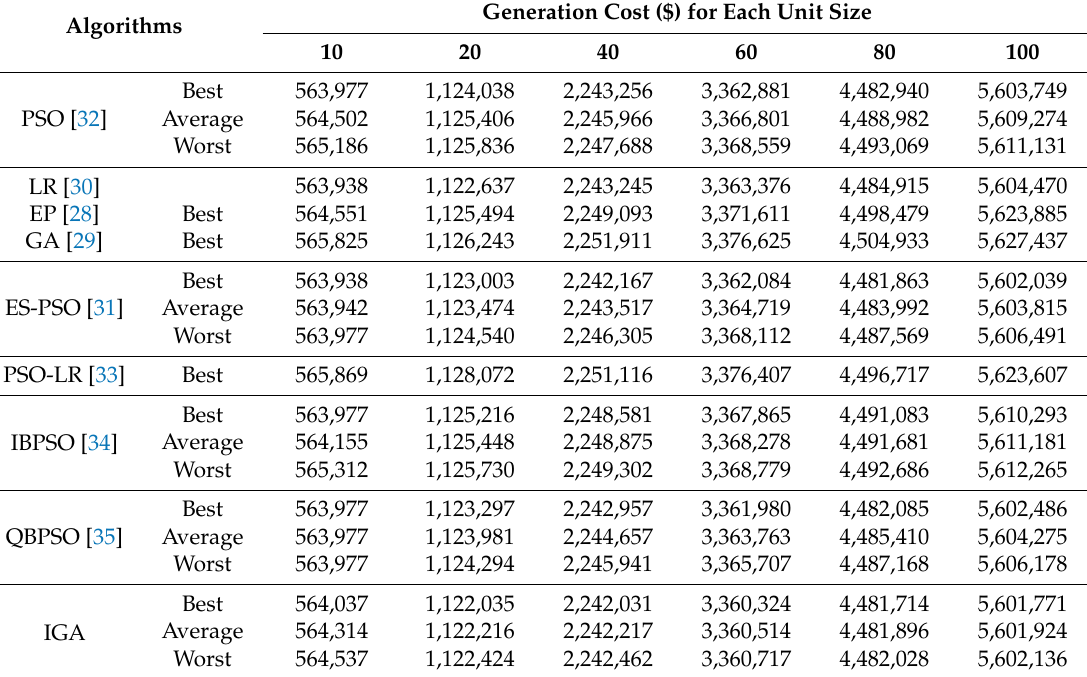
Table 1. Comparison of operating